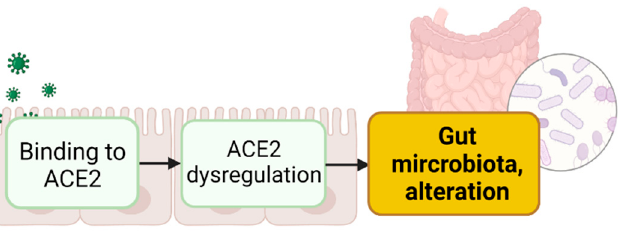
Figure 2. Virus binding to ACE2 expressed in enterocytes induces ACE2 dysregulation leading to alteration in gut microbiota. Created with Biorender.com.